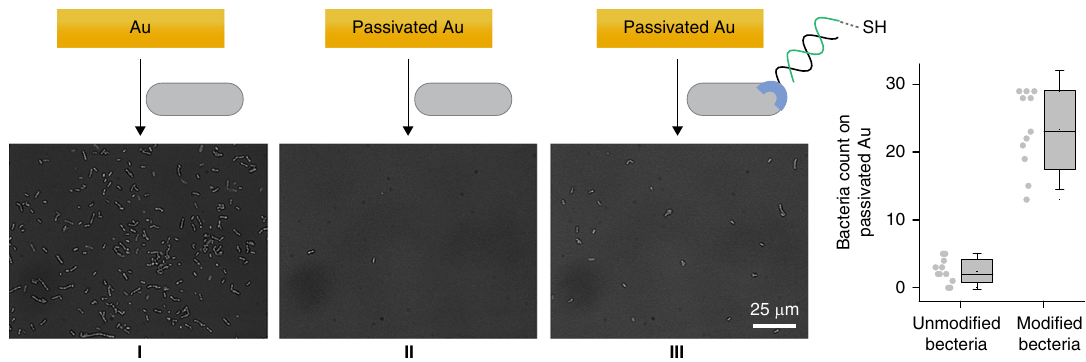
Fig. 5 Programing the bacteria to adhere to surfaces. a Images of the following: (I) bare gold substrate after incubation with unmodi fi ed bacteria, (II) passivated gold substrate after incubation with unmodi fi ed bacteria, and (III) passivated gold substrate following incubation with bacteria modi fi ed with a thiol-modi fi ed duplex (ODN-1: HS-ODN-2). b Average number of bacteria per 0.0165mm 2 of passivated gold. The error bars represent the s.d. of 11 frames. Source data are available in the Source Data fi